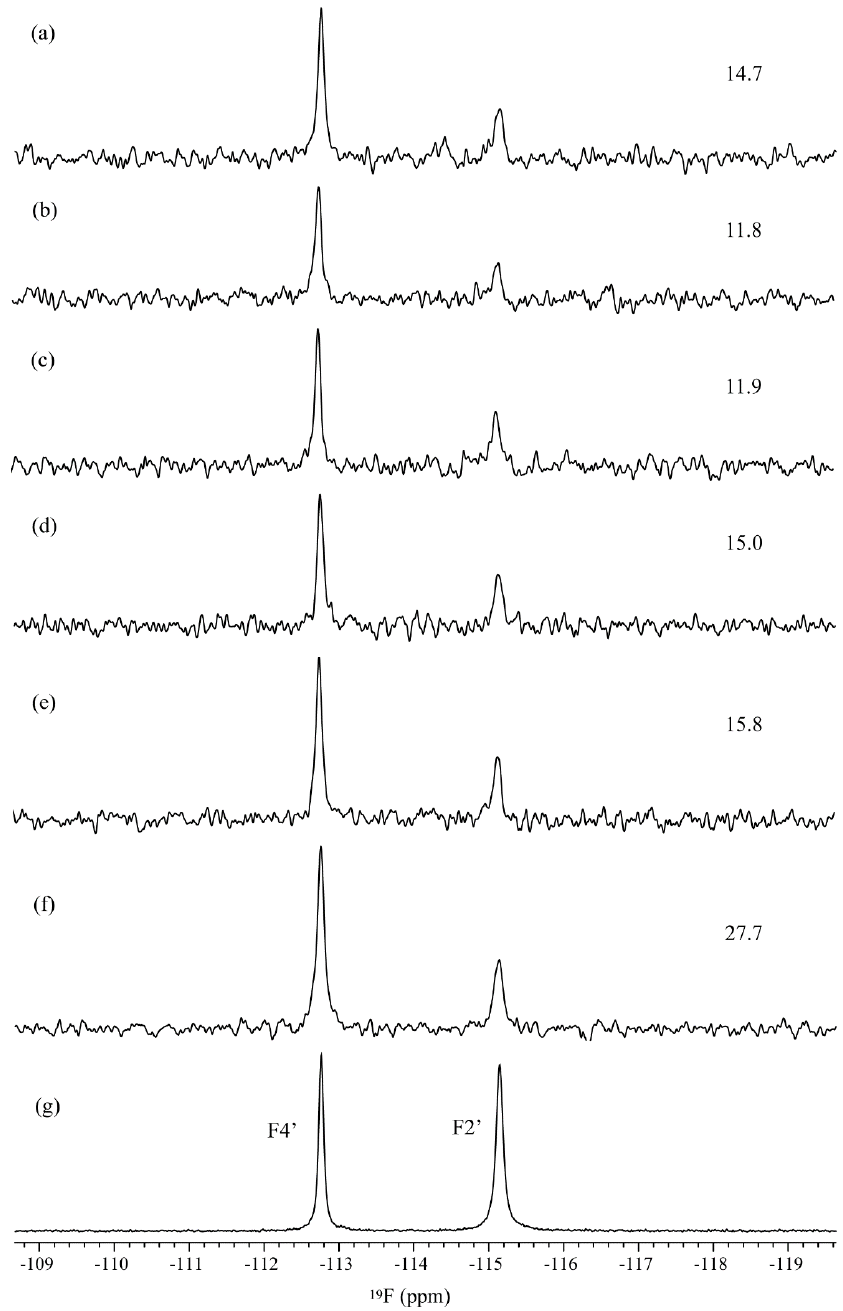
Figure 3. The 19 F{ 1 H} STD spectra acquired using ( a ) a rectangular pulse, ( b ) G3, ( c ) I-BURP-1, ( d ) I-BURP-2, ( e ) Q 3 , and ( f ) Gaussian shaped pulses for 1 H saturation. The S/N ratios calculated using VnmrJ software are shown in each STD spectrum. ( g ) A reference 19 F spectrum.